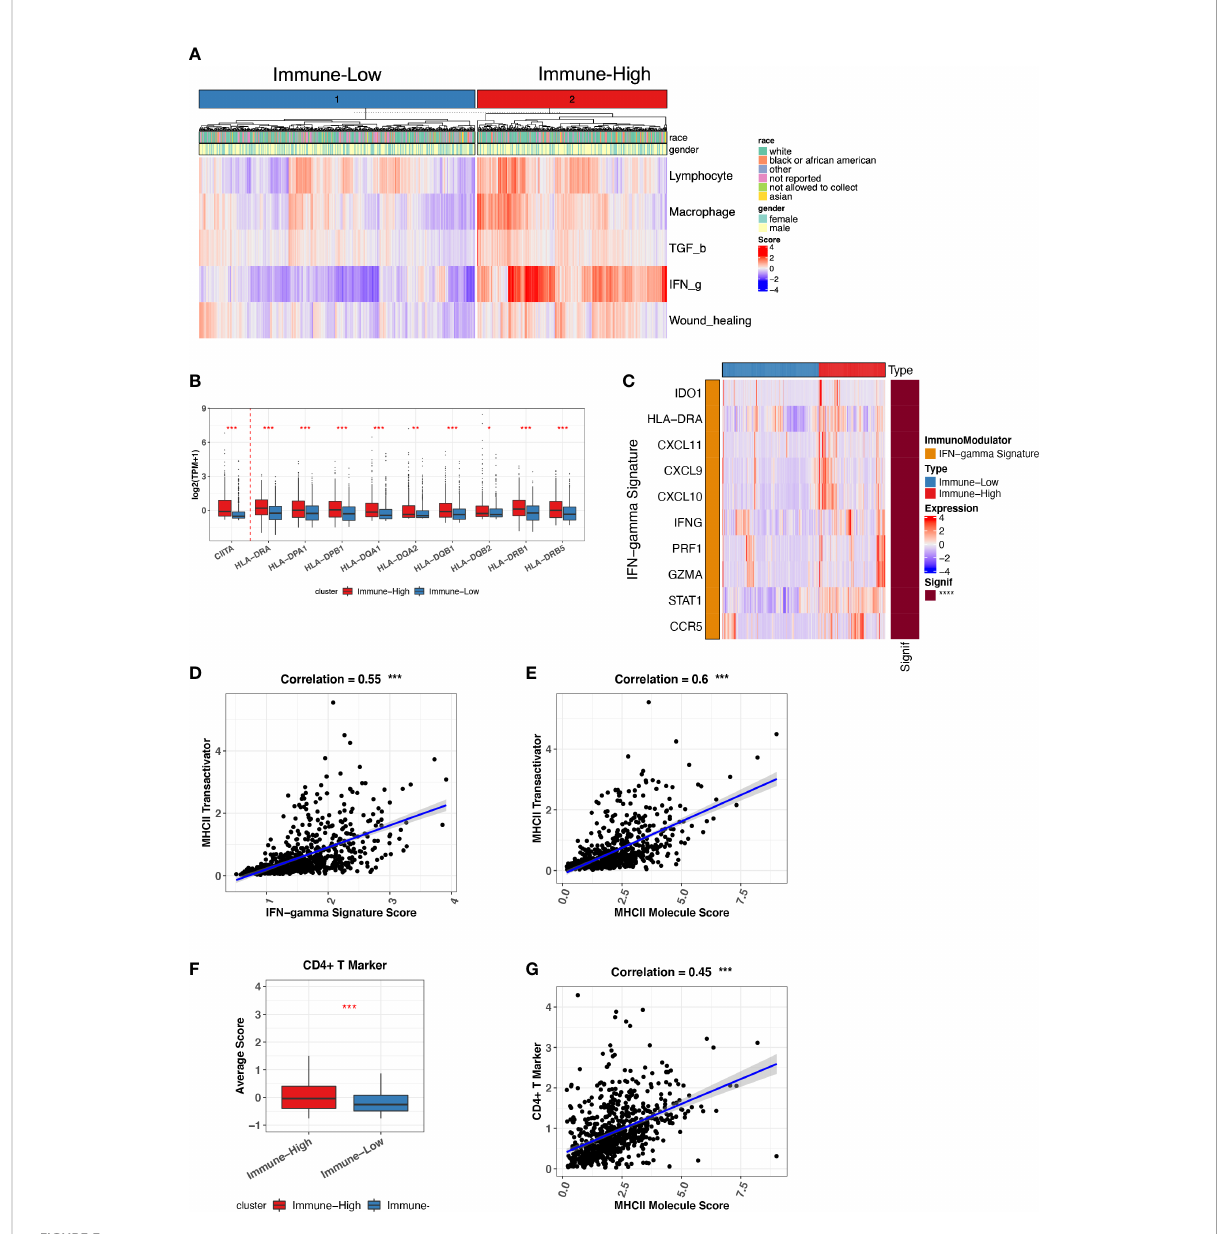
FIGURE 3 Immune-low and Immune-high ND MM tumor classi fi cation based on representative immune signatures. (A) ND MM tumors (x-axis) clustered by representative immune signature score (heatmap colors). The top bar shows race and gender information for each patient. (B) Comparison of CIITA and MHC-II molecules expression between immune-low and immune-high tumors. Asterisks denote signi fi cance level (*** P < 0.001; ** P < 0.01; * P < 0.05; NS P > 0.05). (C) Expression of IFN-g signature genes in immune-low and immune-high tumors. The right bar shows the signi fi cance of gene difference between immune-low and immune-high tumors. (D) The correlation between IFN-g signature score and CIITA expression. (E) The correlation between MHC-II molecules expression and CIITA expression. (F) Average score difference of CD4+ T-cell markers between immune-low and immune-high tumors. (G) The correlation between MHC-II molecules expression and CD4+ T-cell marker